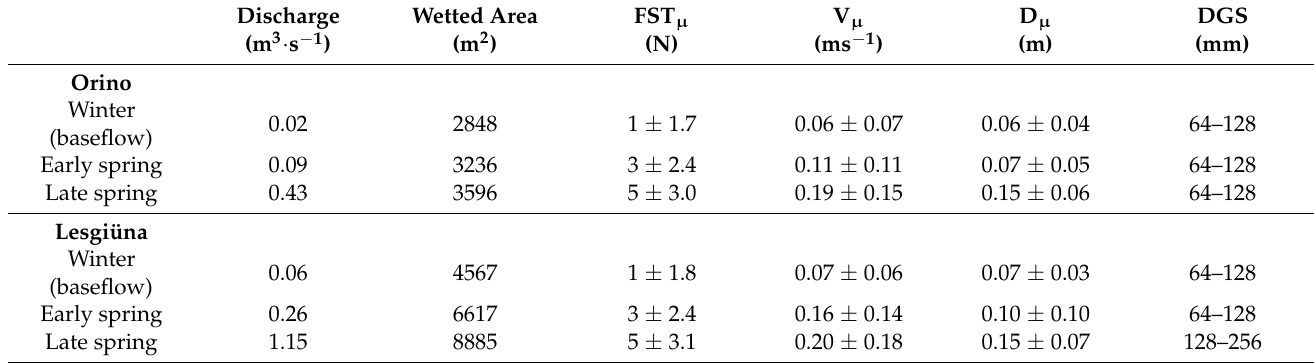
Table 2. Measured values of wetted area; FST µ , mean FST number approximated to the closest unit; V µ , mean velocity; D µ